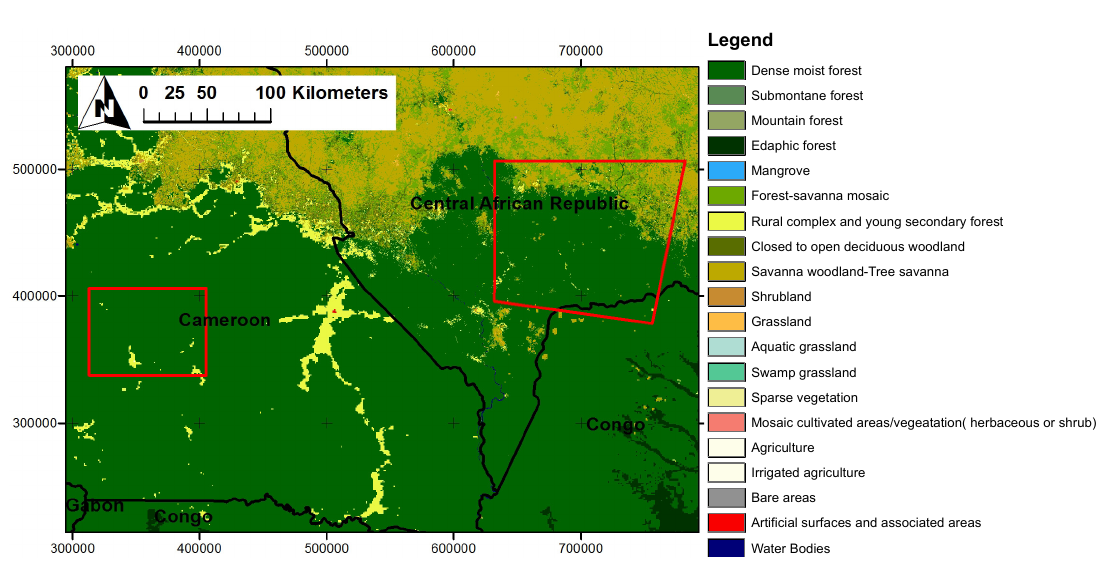
Figure 1. Location of the two study sites in Cameroon and Central African Republic with a Congo Basin vegetation types map as background [40]. The areas marked in red represent the study